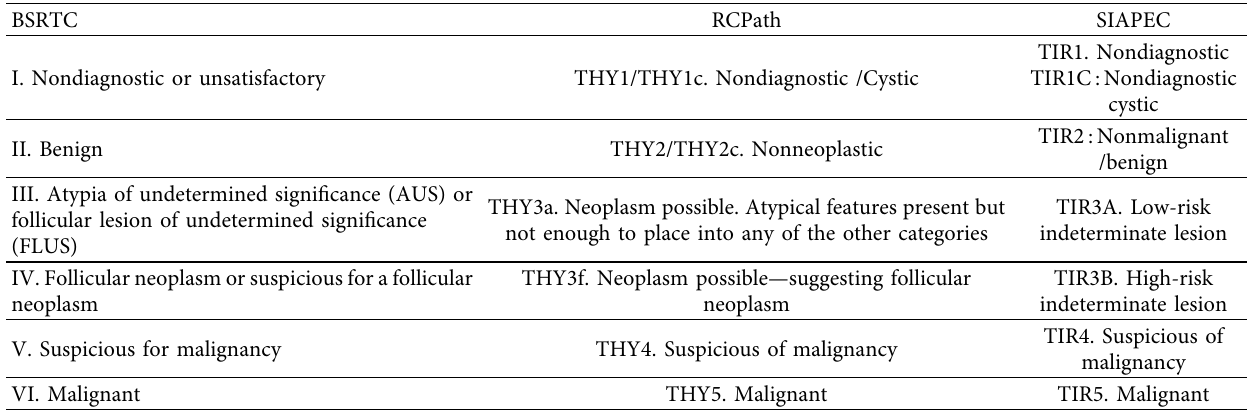
Table 1: Comparison of the Bethesda, the RCPath, and the SIAPEC diagnostic categories.